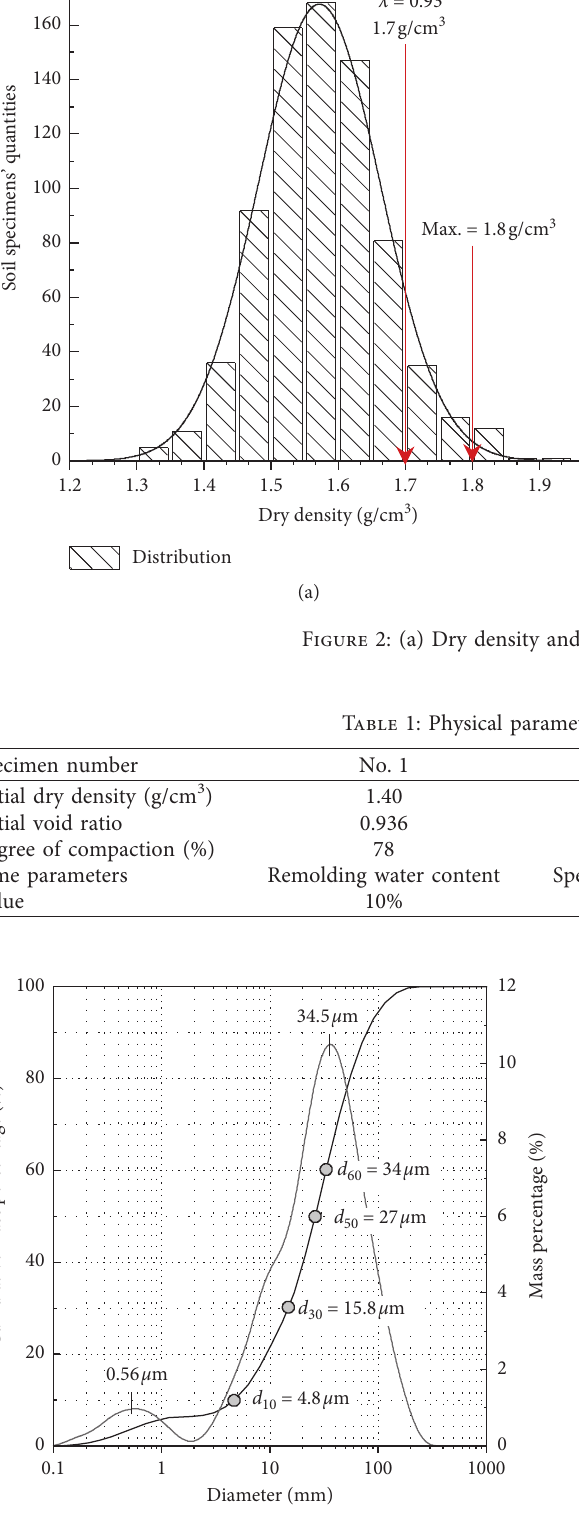
Figure 3: Curves of particle size